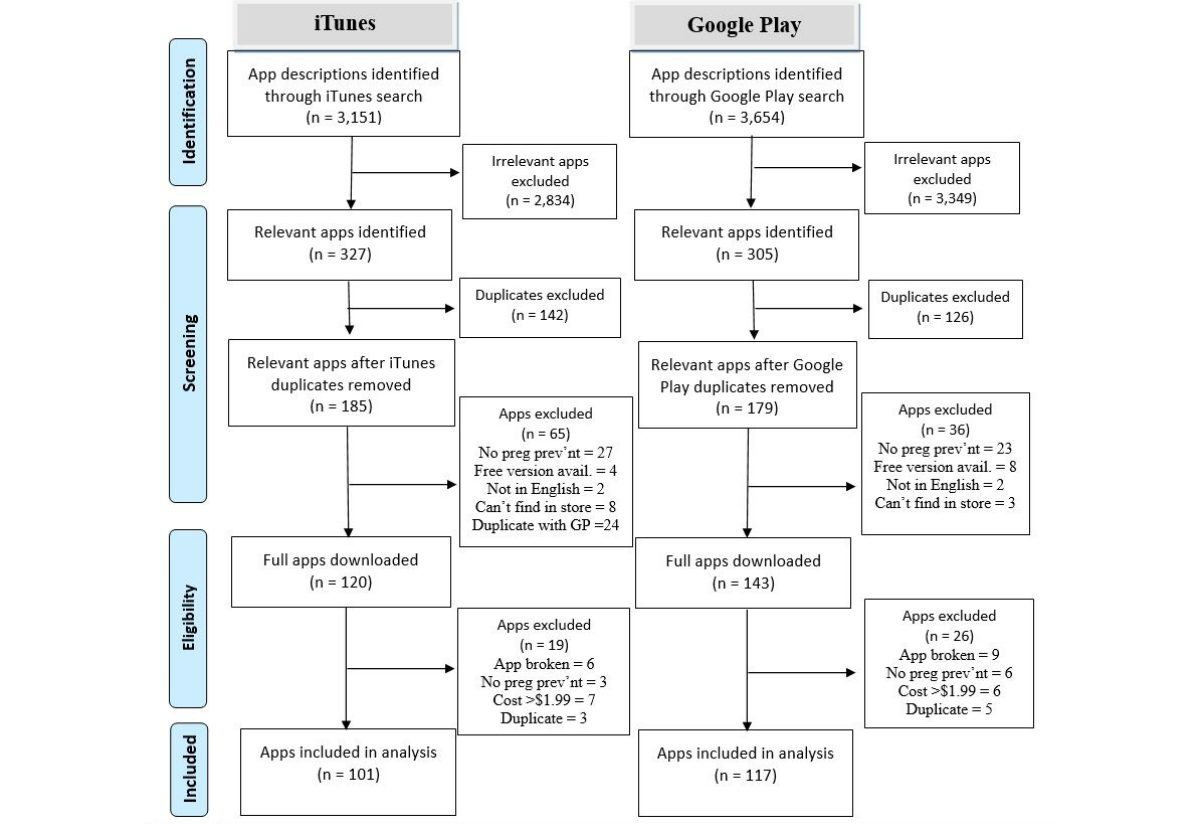
Figure 1. PRISMA diagram for iTunes and Google Play search